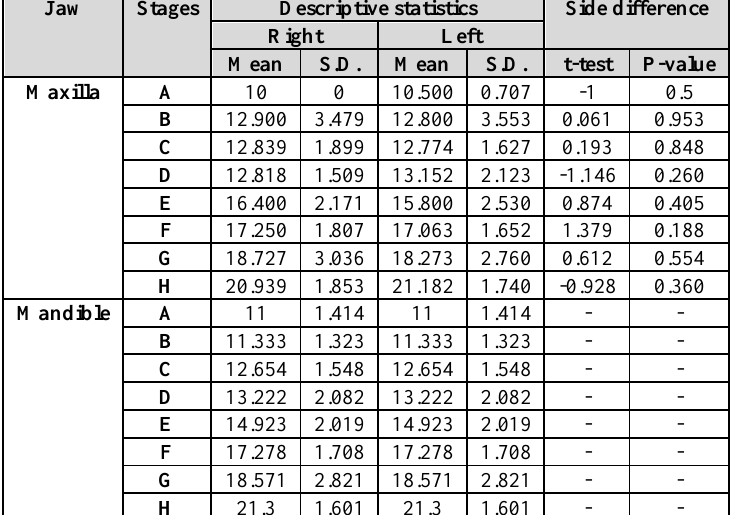
Table 6: Descriptive statistics and side difference of the age (in years) for each developmental stages of maxillary and mandibular third molar in